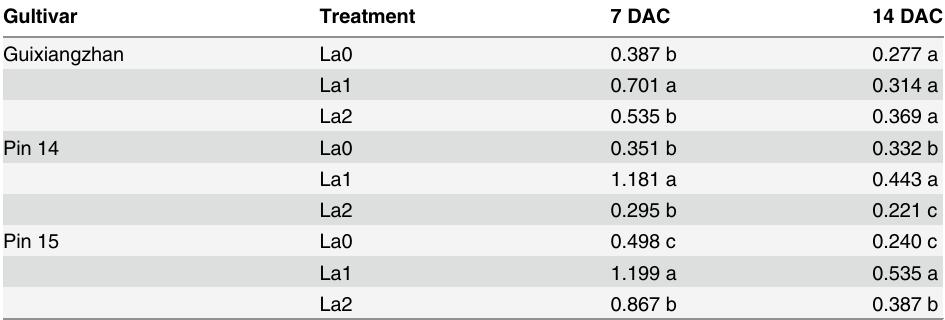
Table 2. Effect of La supplementation on ProDH activity (U g -1 FW) in grains of detached aromatic rice panicles in vitro .